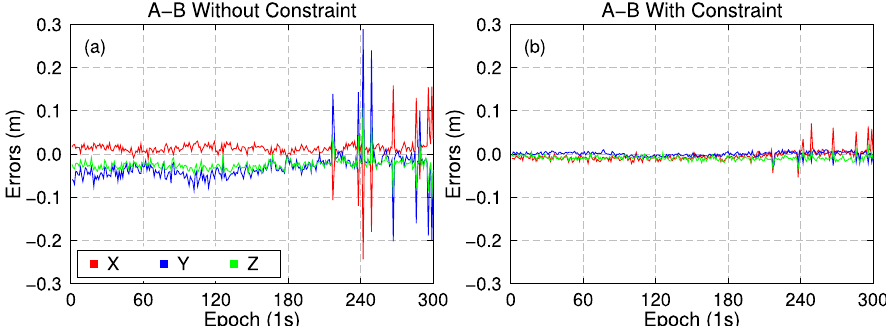
Figure 14. L1/B1 ambiguity float solutions of baseline A–B without ( a ) and with ( b ) static levelling constraint.